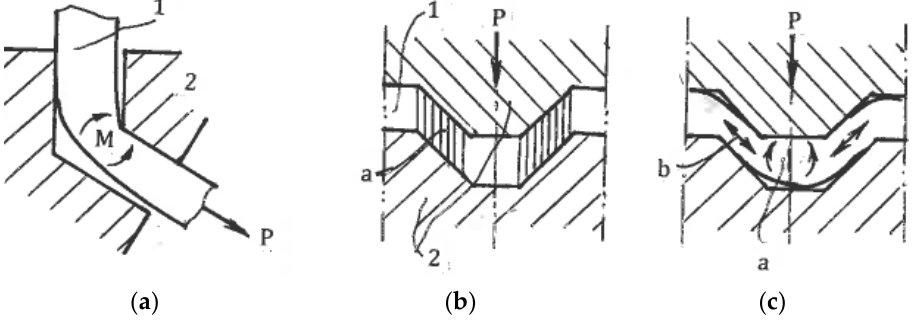
Figure 18. Simple shear imitation: ( a ) Equal-channel angular drawing; ( b ) Supposed shear zones during constrained groove pressing (CGP); ( c ) Actual tensile–bending zones during CGP.